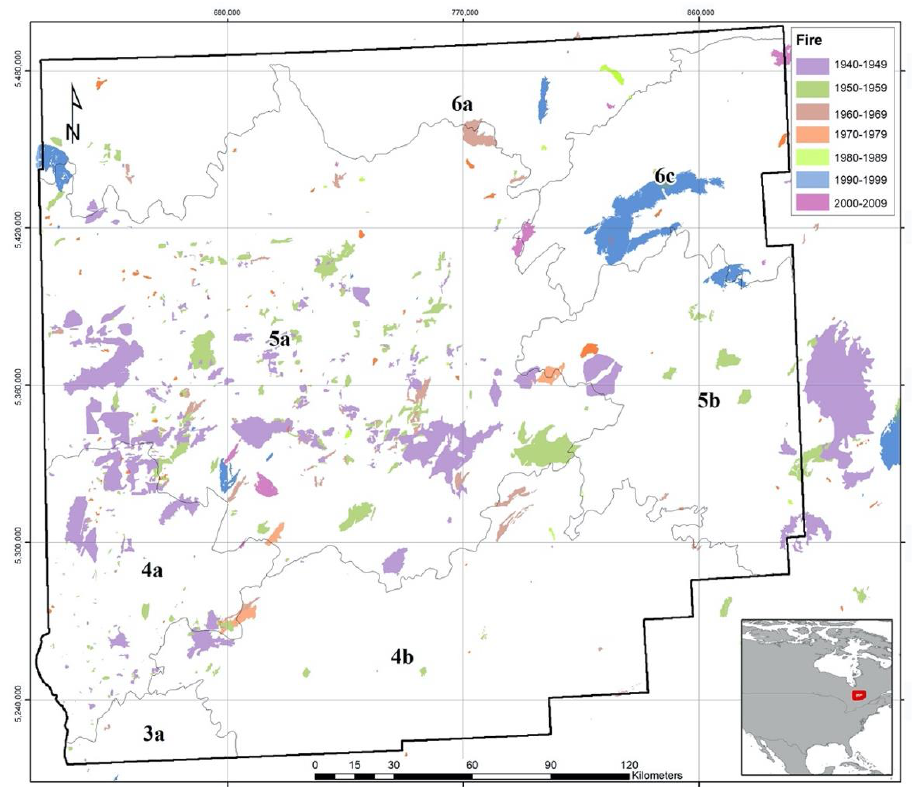
Figure 1. Study area in the Boreal Forest of Quebec with the ecoregions and historical fires classified by decade. The black line corresponds to the delimitation of the ecological regions 4a, 4b, 5a, 5b, 6a, and 6c. Ecological regions 4a and 4b (temperate mixedwood forests), 5a and 5b (boreal mixedwood forests), 6a and 6c (boreal conifer forests). See Table 1 for the detailed descriptions of the ecological regions.